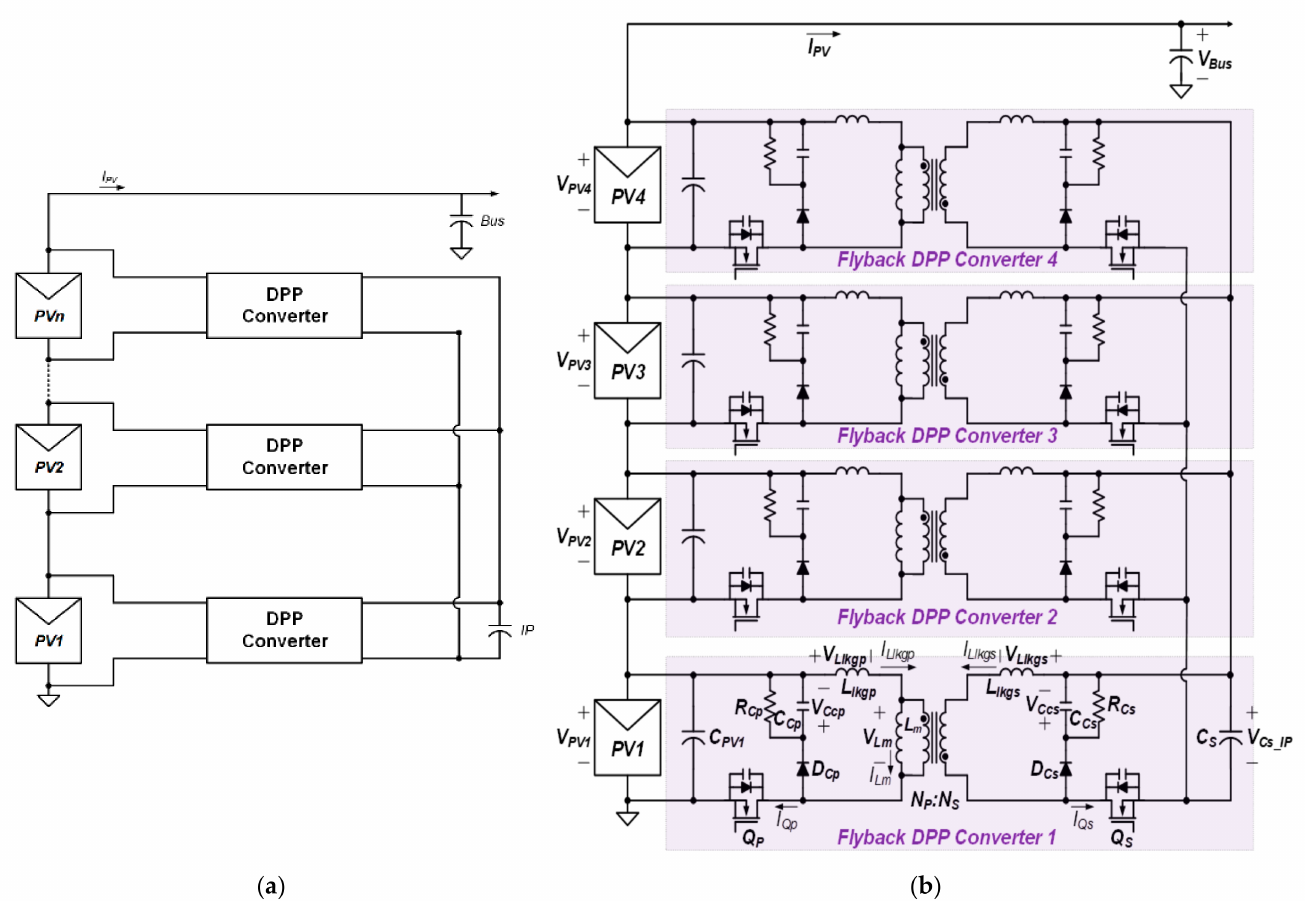
Figure 1. A conventional flyback Differential Power Processing converter ( a ) architecture and ( b ) cir- cuit